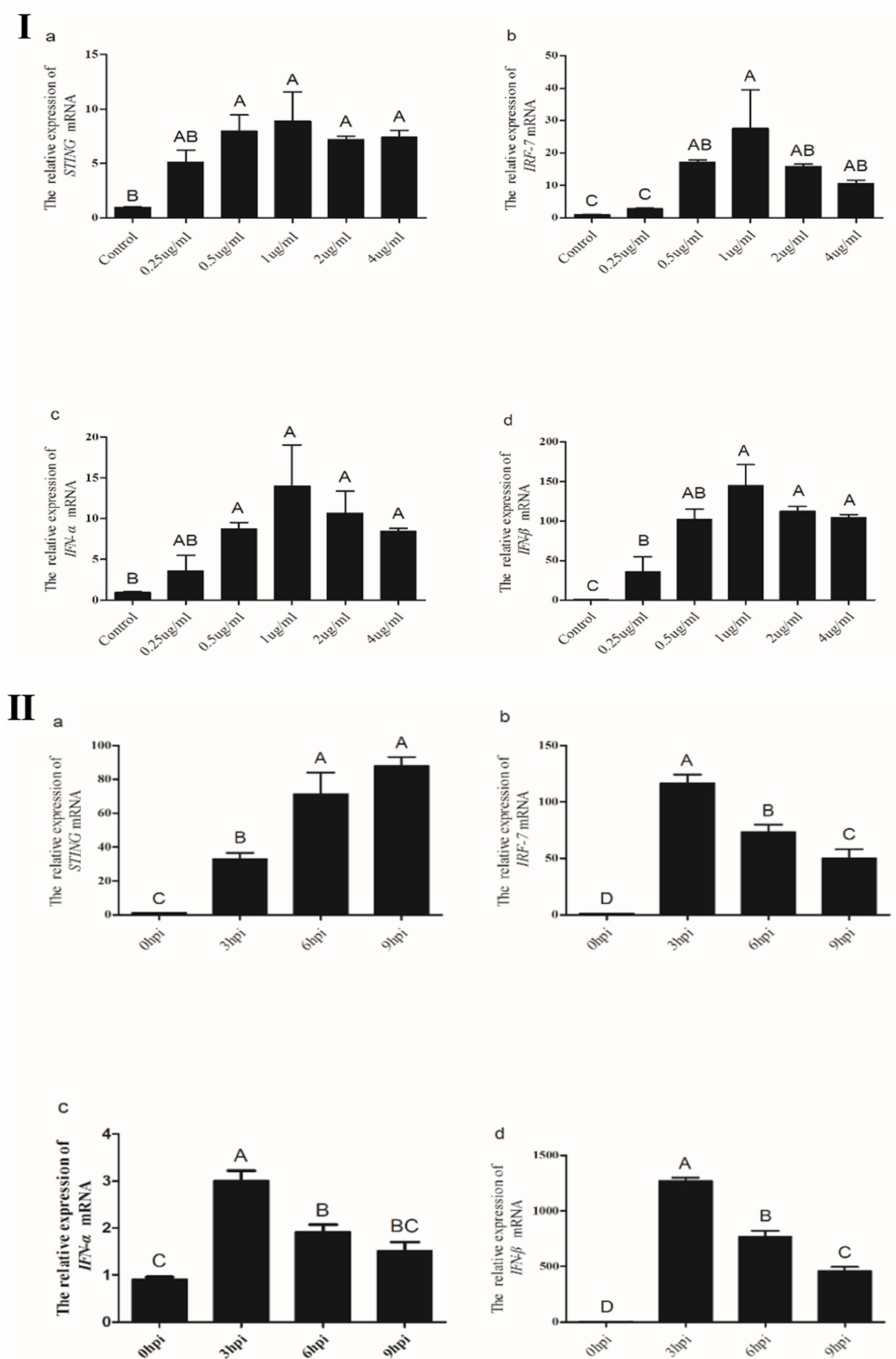
Figure 8. The expression levels of STING , IRF7 , IFN- α and IFN- β genes in CEFs after transfection with poly(I:C). (I) CEF were transfected with different doses of poly(I:C) for 9 h and then analyzed for the expression levels of STING , IRF7 , IFN- α and IFN- β genes by real-time PCR. (II)After transfection with the poly(I:C), the expression levels of STING , IRF7 , IFN- α and IFN- β genes in CEFs were analyzed at 3, 6, 9 h, respectively. All data shown are the mean ± SD ( n = 3) and subjected into one-way ANOVA to identify differences between groups. Columns sharing different capital letters show significant difference ( p <